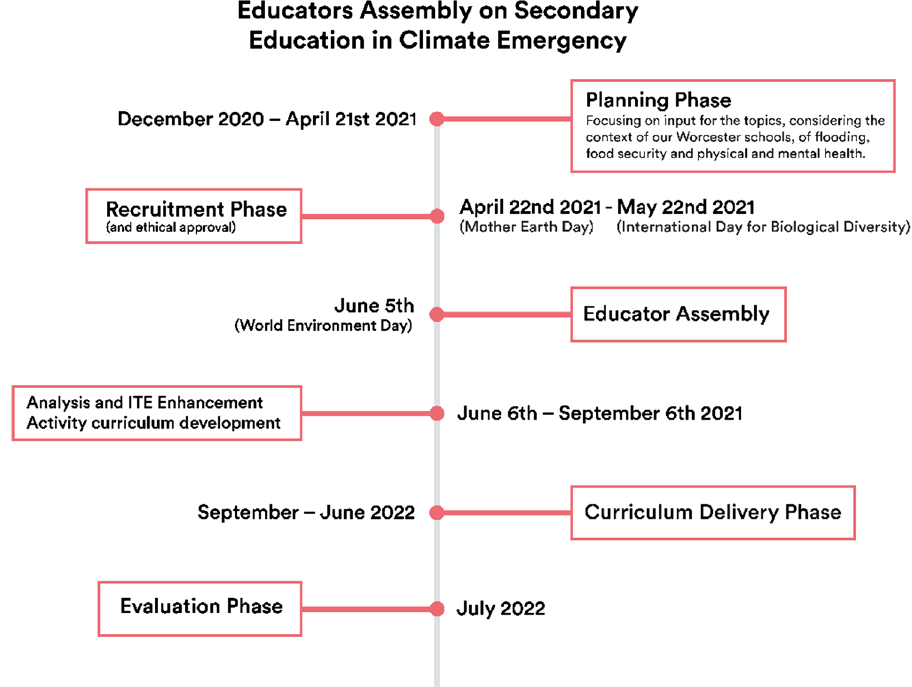
Fig. 2 Green Impact Educa- tor Climate Assembly